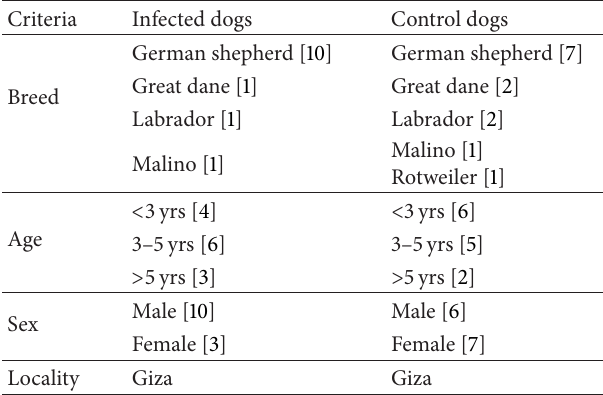
Table 1: Age, sex, breed, and locality of control and infected dogs.